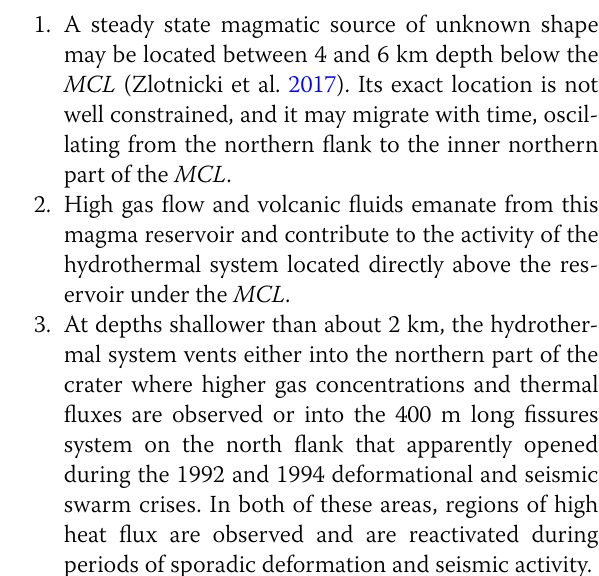
been generated by a change in pressure (or volume) of a source at a depth of about 5 km beneath Daang Kastila (DAK—Fig. 1b) in 2000, and under the eastern shore of MCL (MCL—Fig. 2a) in 2005. It is consistent with the concept of episodic inflation phases being caused by intermittent intrusions of magma into a shallow reser- voir of magma at about 5 km depth and deflation phases caused by exsolution of magmatic fluids and gases into an overlying unconfined, but not yet identified at that time, hydrothermal system.